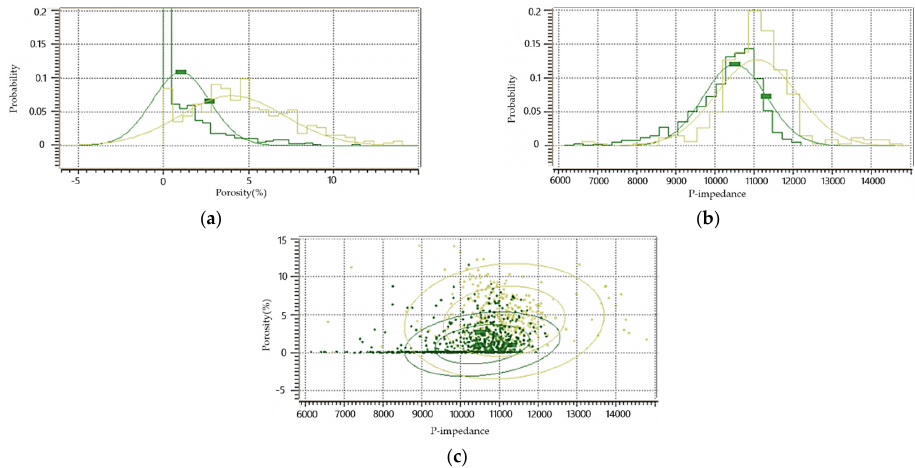
Figure 6. ( a ) Gas and non-gas porosity histogram, ( b ) Gas and non-gas P-impedance histogram, ( c ) Cross-plot of Porosity and impedance of gas and non-gas layer.